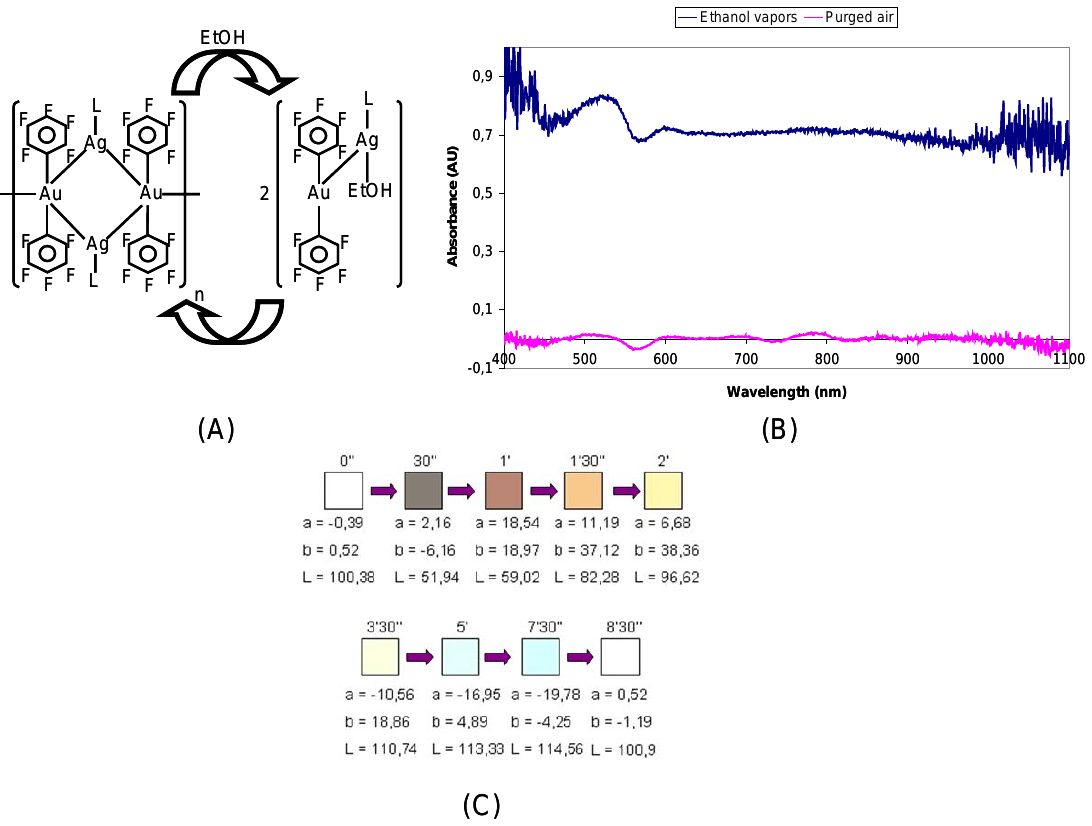
Figure 14. Example of a sensing material: (a) the complex suffers a reversible change in its structure in presence of ethanol vapors, (b) this can be measured in terms of color change registering the absorbance spectra when illuminating it with a white light source, (c) and CIELab, L, a, b, parameters of the color of the reflected signal can be also used to probe the optical